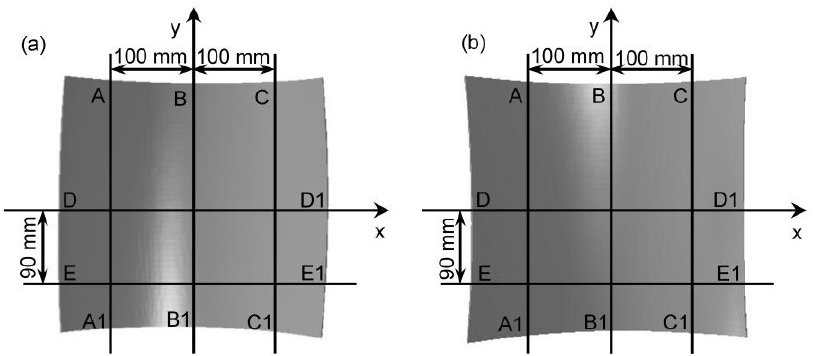
Figure 13. Different measuring positions of 3D surfaces: ( a ) convex surface; ( b ) saddle surface.